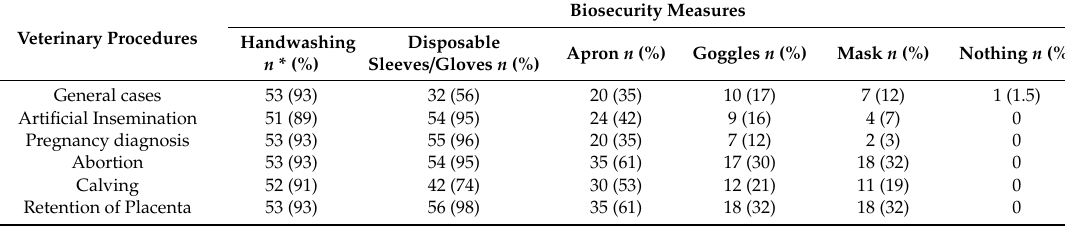
Table 5. Numbers ( n ) of veterinary professionals following various biosecurity measures during and after performing a veterinary procedure based on the response to the questionnaire survey during dairy value chain study conducted in Punjab, India during 2018–2019. The respondents could choose more than one